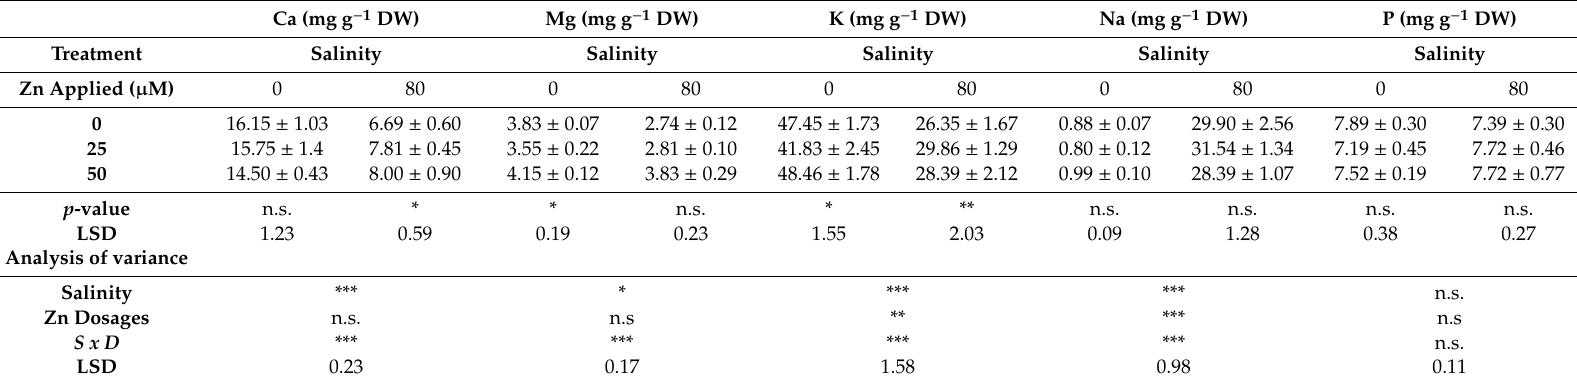
Table 4. Macronutrient concentrations of roots of pak choi plants grown with di ff erent salinity and / or Zn treatments. Values are means ± SE ( n = 3).